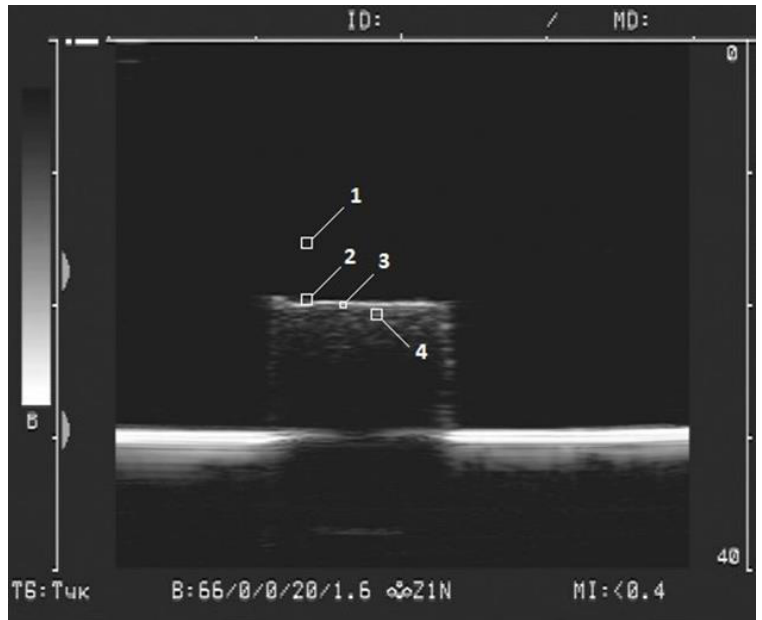
Figure 3. Example of ferrogel visualization. (PAAm/Xanthan, 12.9% of MPs). Squares with marks 1 – 4 illustrate locations where specific parameters of brightness were calculated. See also explanation in the text.